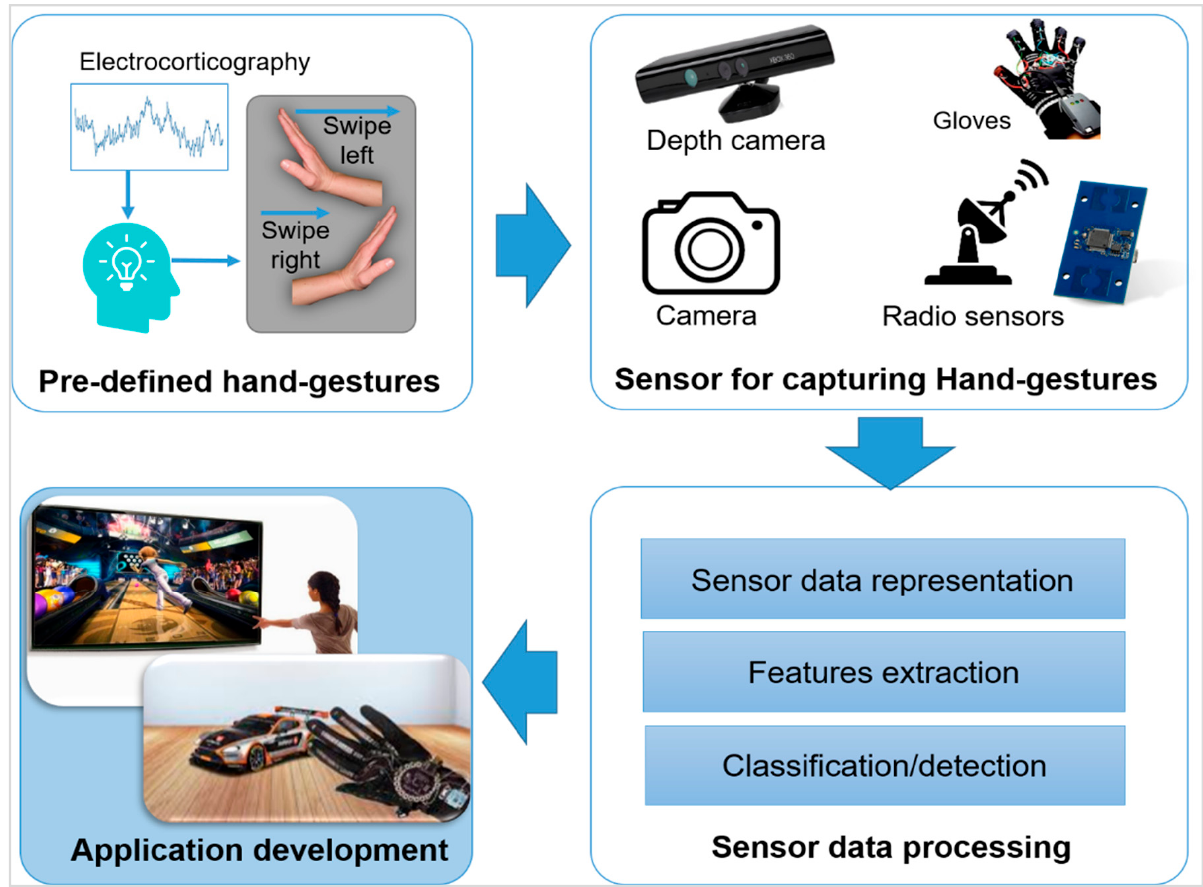
Figure 2. Pipeline of hand gesture recognition (HGR)-based HCI design. (1) User performs pre-defined hand gestures, (2) the performed gesture is captured with different sensors, (3) sensor data are digitized and formatted in an appropriate way and (4) finally, the devices are controlled.